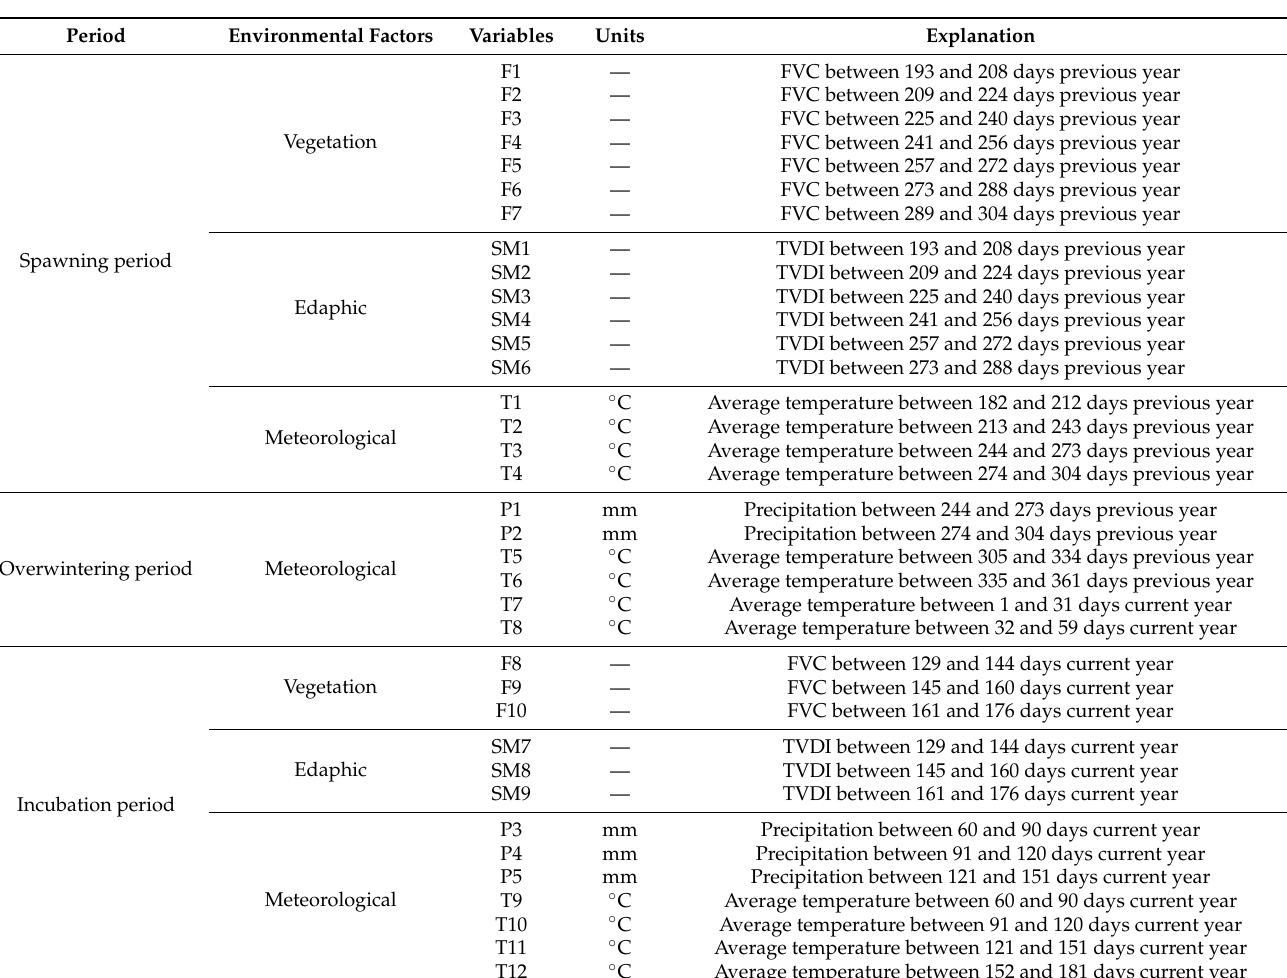
Table 2. Environmental factors selected in this study.